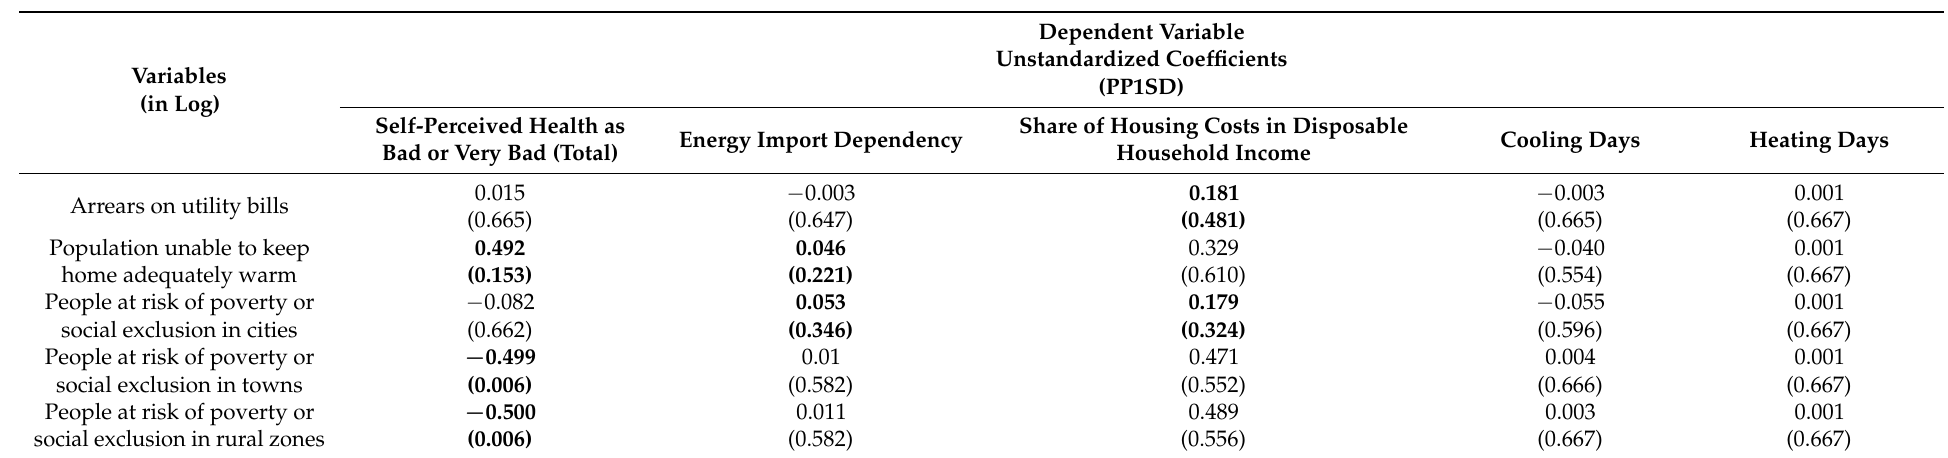
Table 10. The results of generalized ridge regressions for Cyprus.